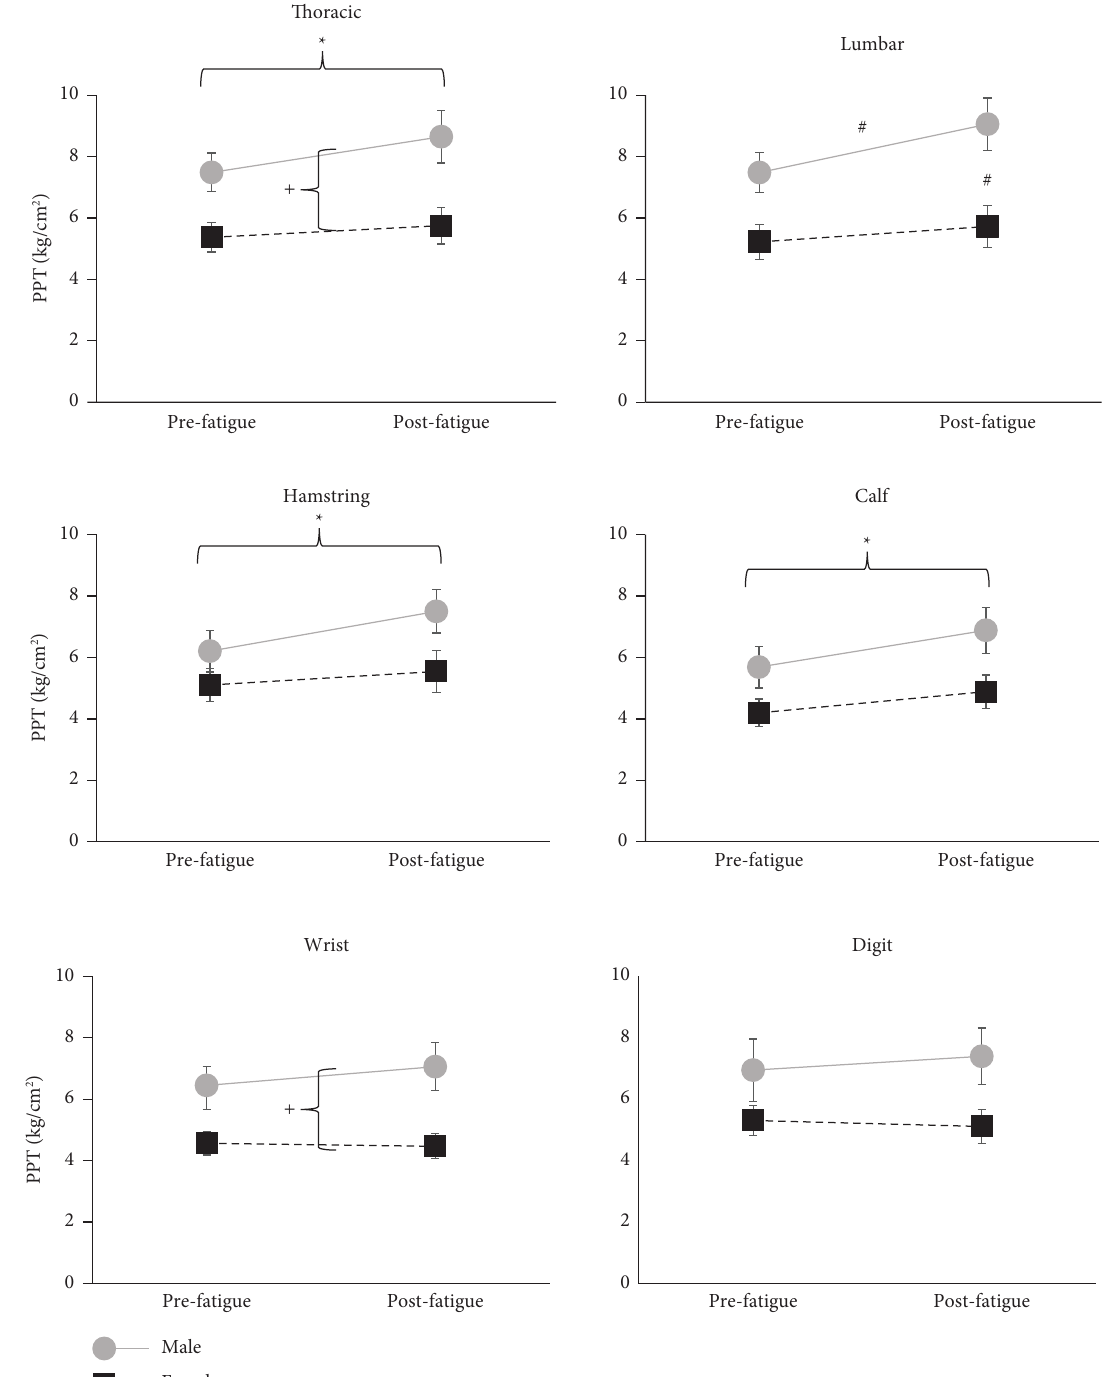
Figure 2: Pressure-pain threshold (PPT) prefatigue and postfatigue in male and female participants. ∗ indicates signifcant main efect of fatigue. + indicates signifcant main efect of group. # indicates signifcant pairwise post hoc comparison for interaction between fatigue and